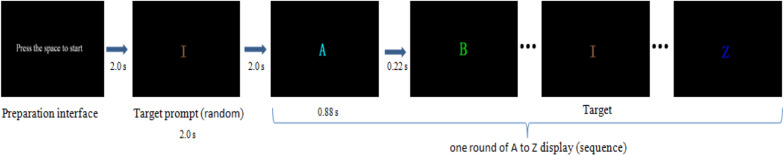
The RSVP paradigm in one round.